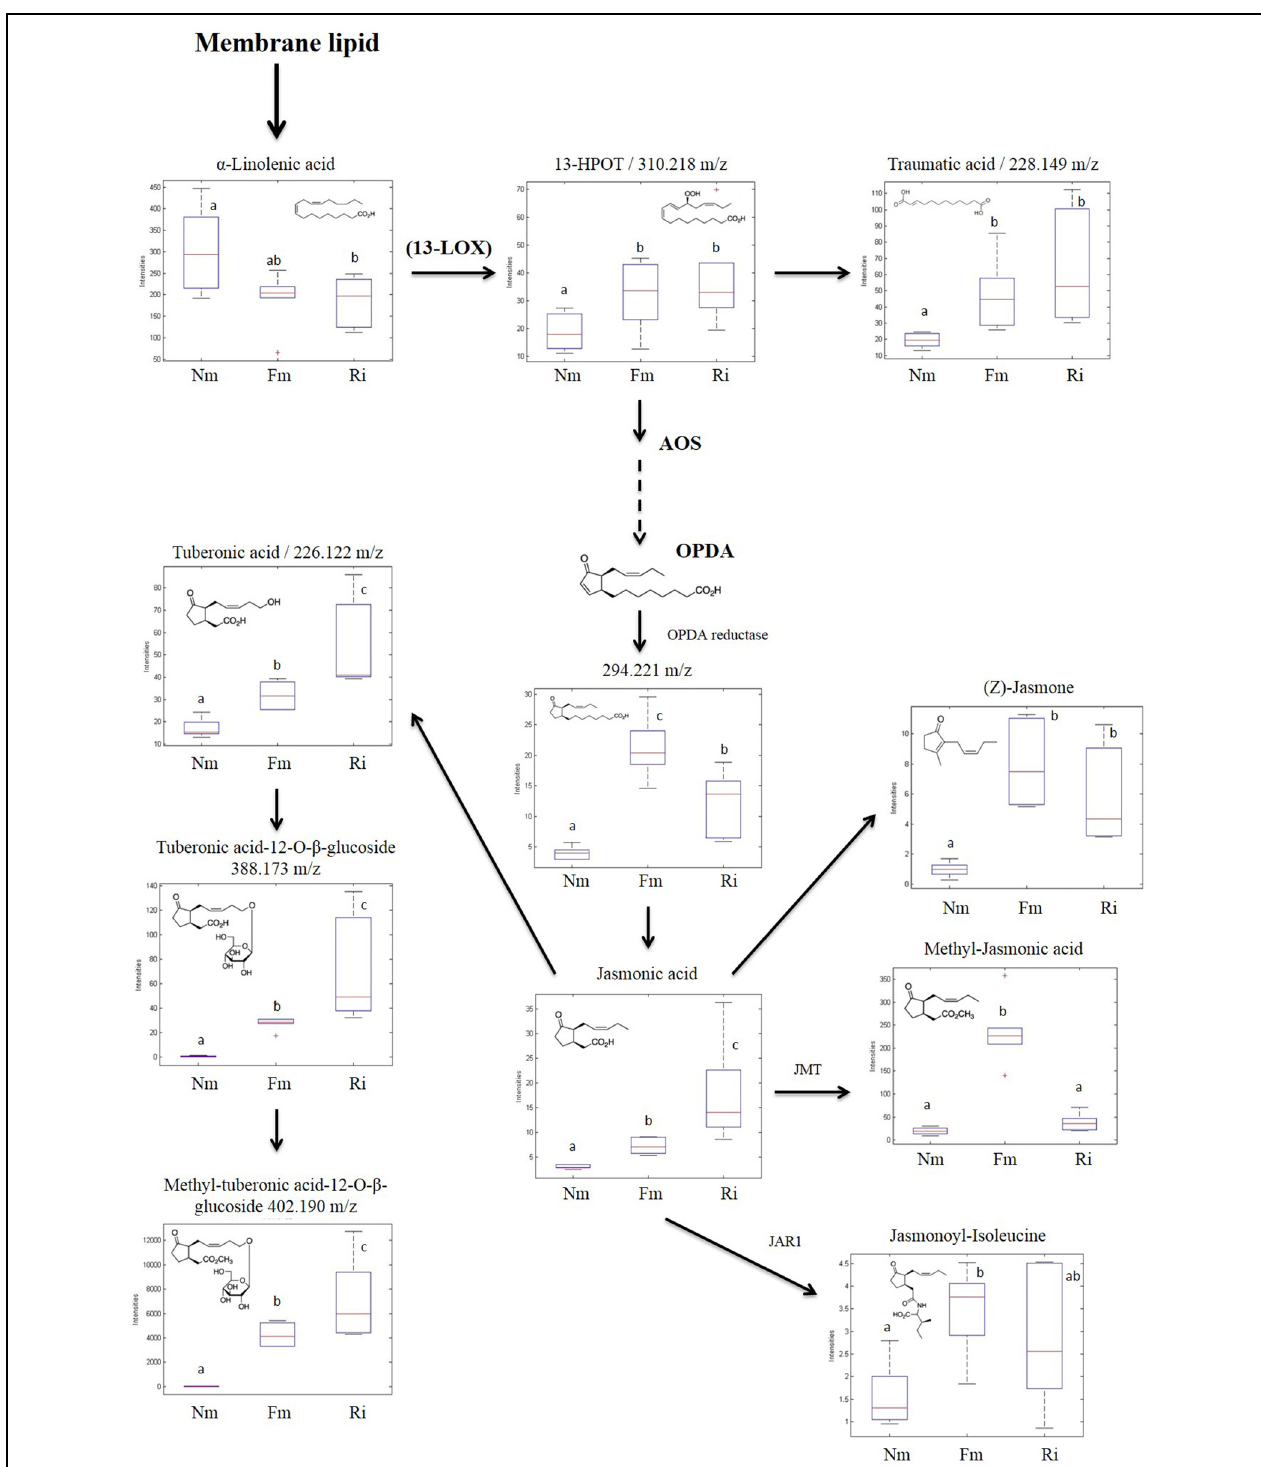
FIGURE 5 | Accumulation profile of compounds related to the 13-LOX oxylipin pathway. Non-mycorrhizal (Nm), F. mosseae (Fm) and R. irregularis (Ri) colonized roots were processed for relative quantification analysis by HPLC–QTOF MS. Concentration of metabolites was determined in all the samples by normalizing the chromatographic area for each compound with the dry weight of the corresponding sample. For those compounds matching two or